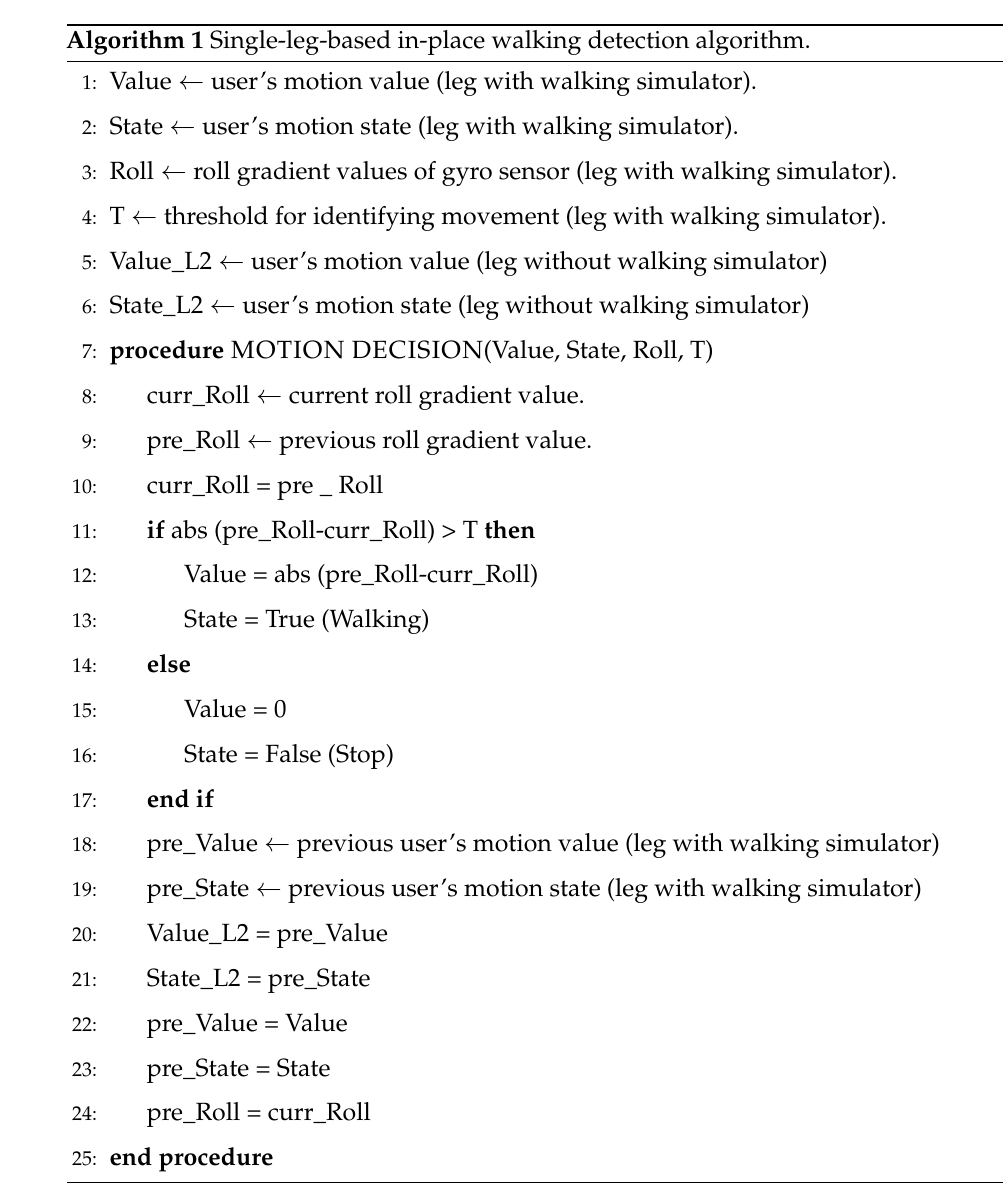
Algorithm 1 Single-leg-based in-place walking detection